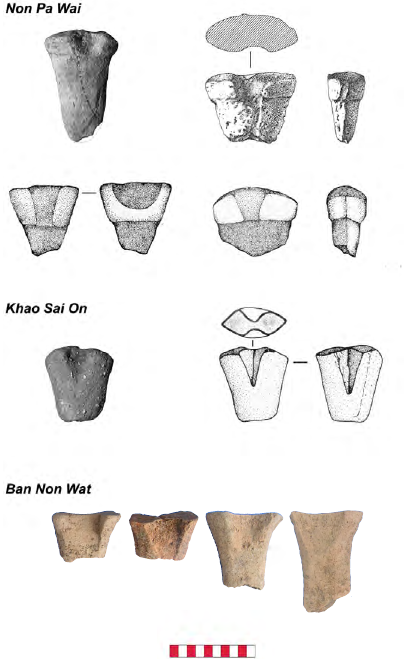
Fig. 8: Marine shell ornaments were manufactured in the Lopburi area and worn by Bronze Age men, women and children in the Mun Valley.